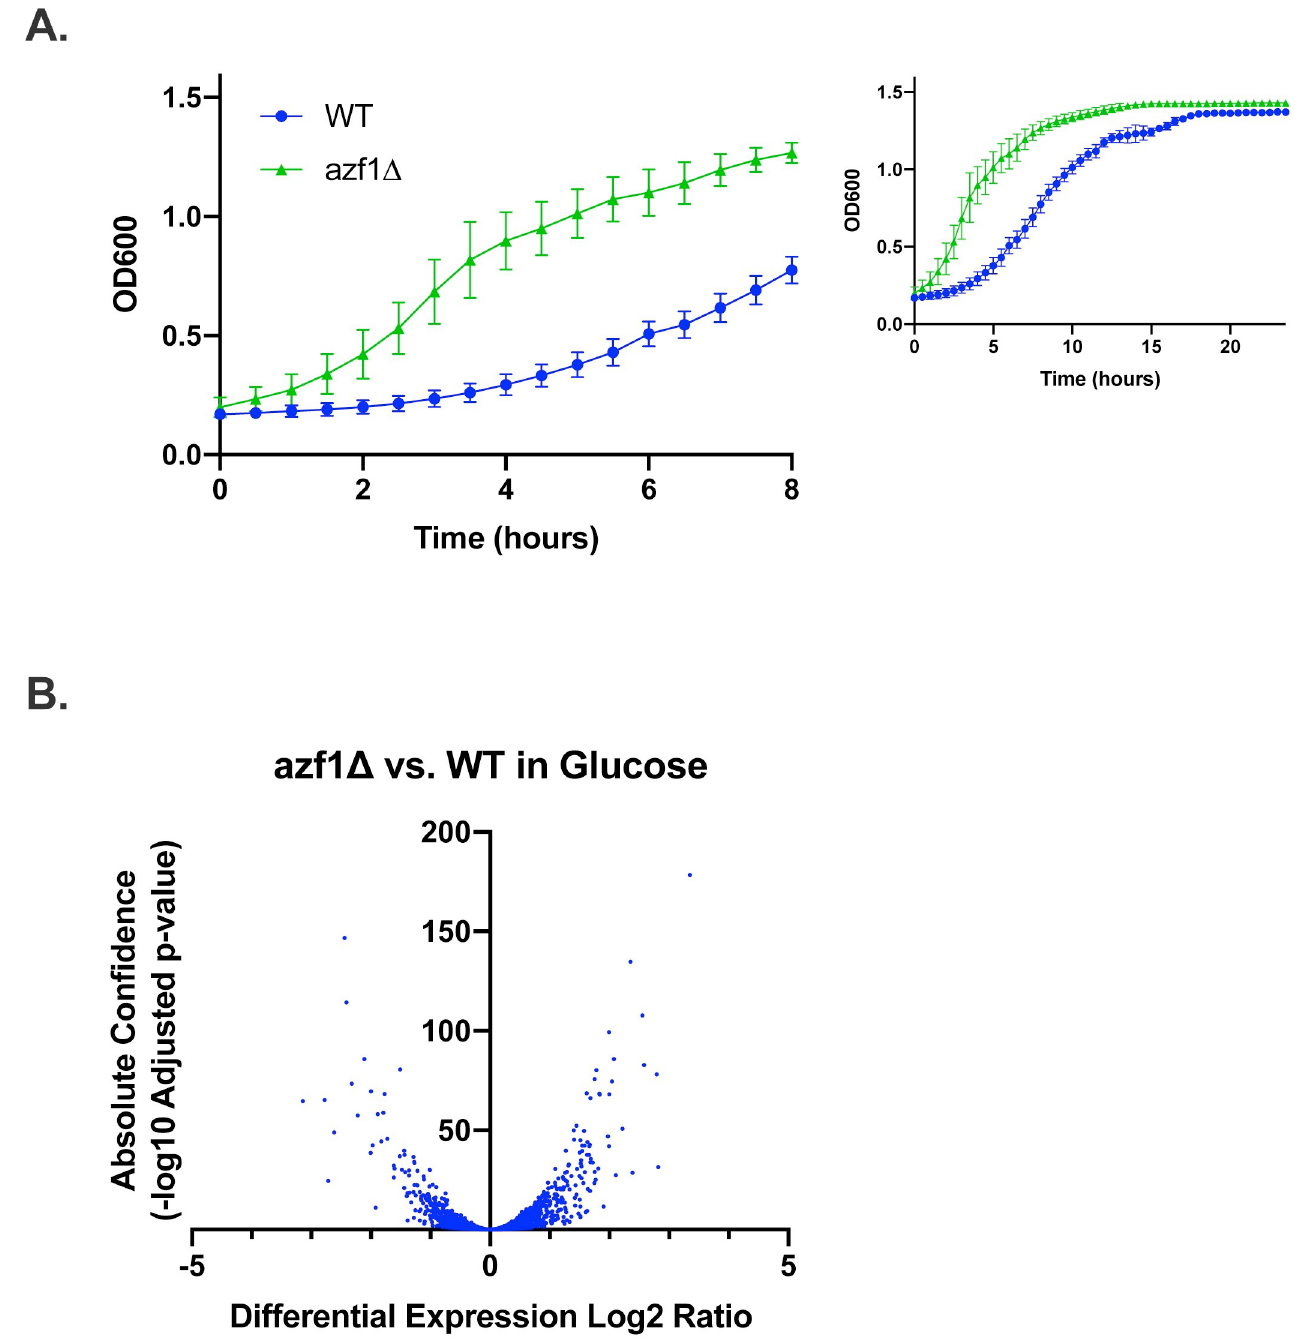
Fig 1. azf1 Δ shortens lag phase during growth in glucose. A) Growth of WT and azf1 Δ with glucose as the carbon source. Growth was measured by OD 600 in a plate reader for 24 hours. The first 8 hours are highlighted to show the differences in growth more clearly and due to the reduced accuracy of the plate reader at high optical densities. azf1 Δ has a dramatically shorter lag phase than WT. Growth curves are the average of three biological replicates, and error bars indicate standard deviation. B) Volcano plot showing genes that are differentially expressed in azf1 Δ compared to